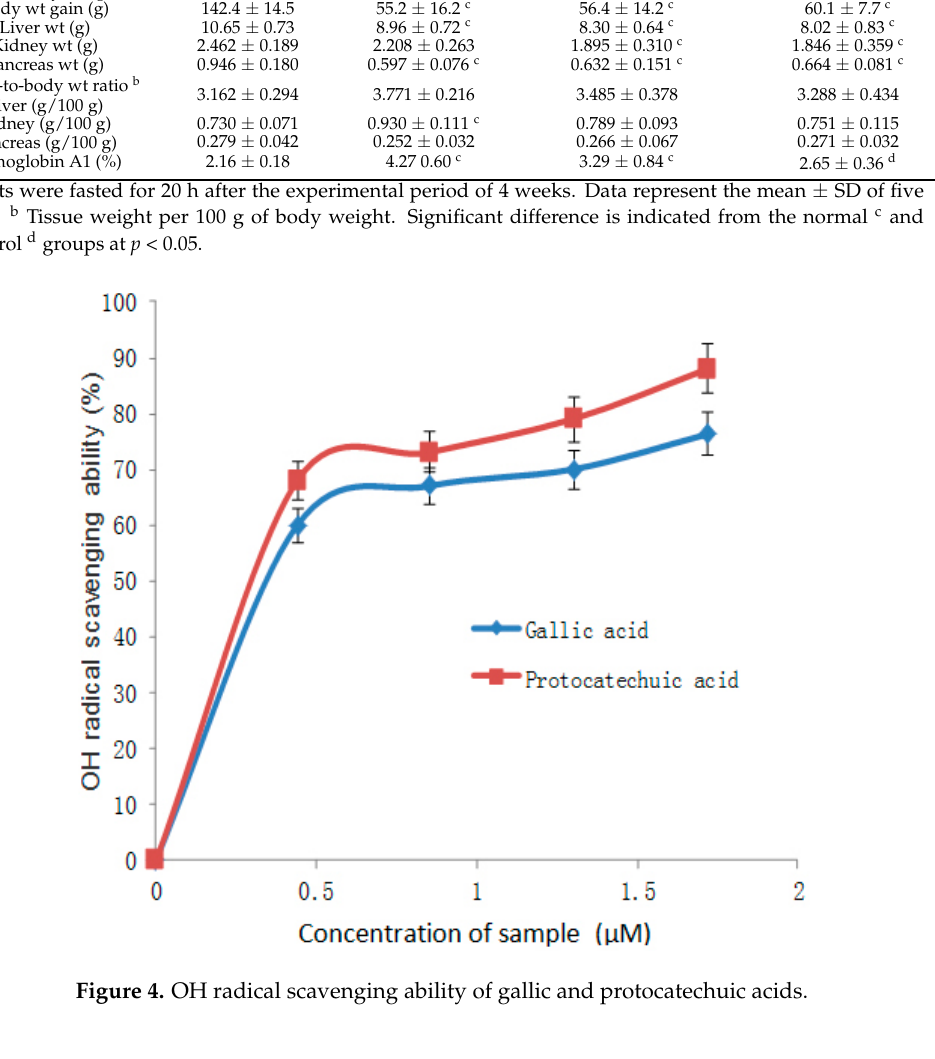
Table 1. Fasted body weight, body weight gain, tissue weight, ratio of tissue-to-body weight and hemoglobin A1 of rats after the experiment for four weeks a [23]. Wt, Wt Gain and Ratio Normal Control Crude Extract of V. dilatatum Fruit-Low Crude Extract of V. dilatatum Fruit-High